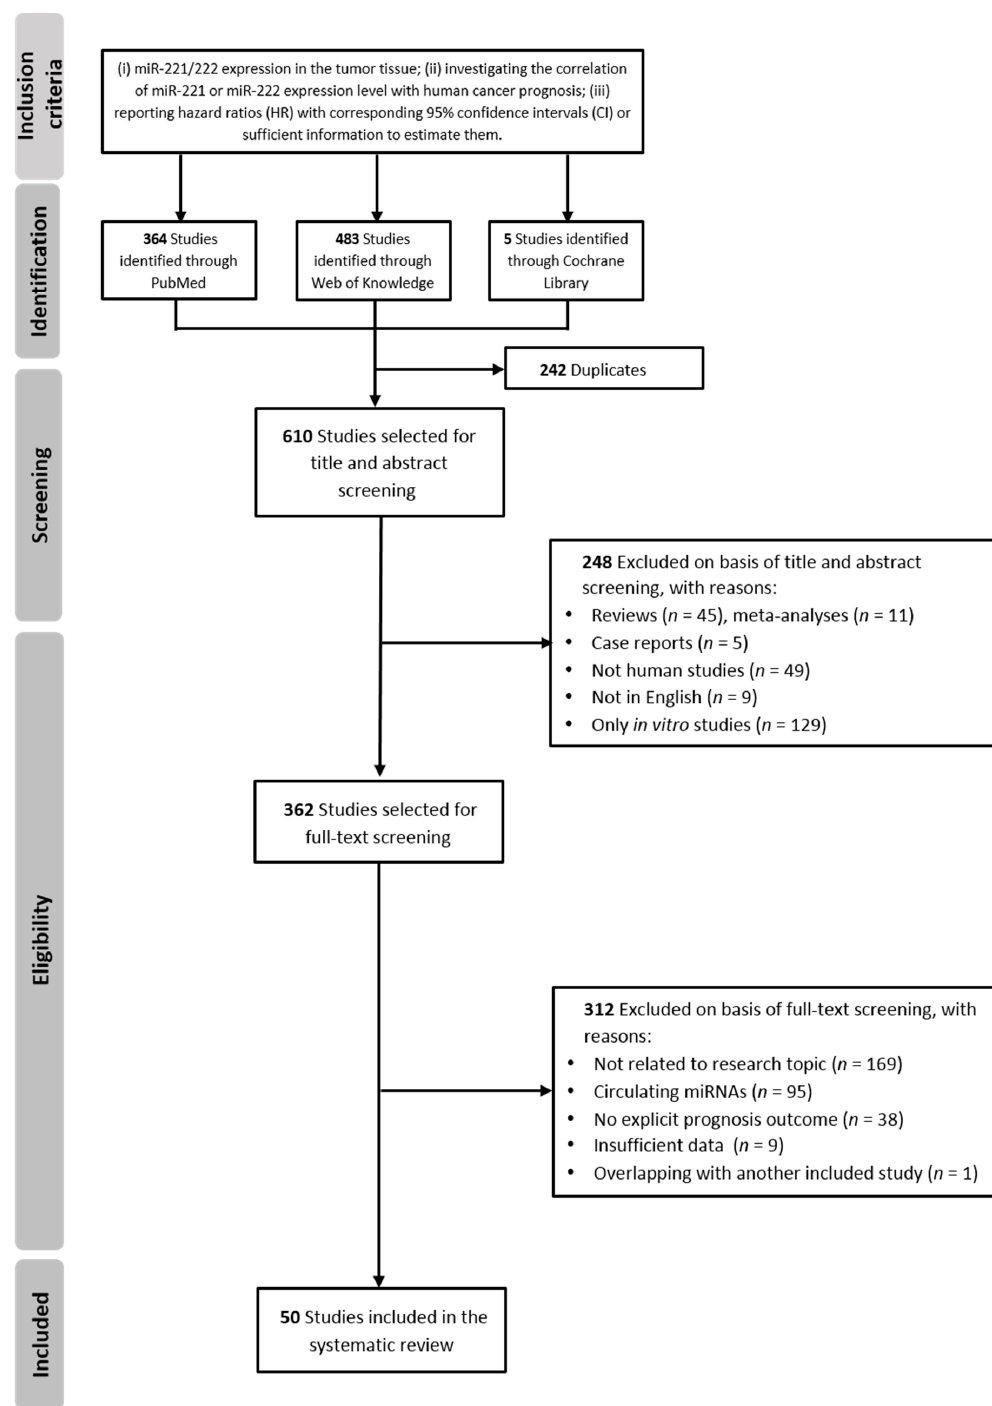
Figure 1. Flowchart of the literature search and selection process of eligible studies.